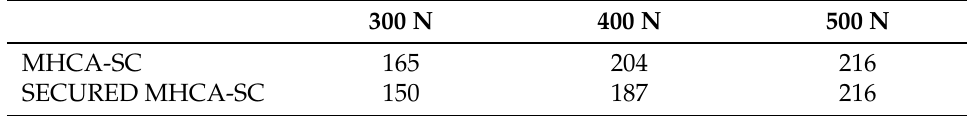
Table 3. First dead